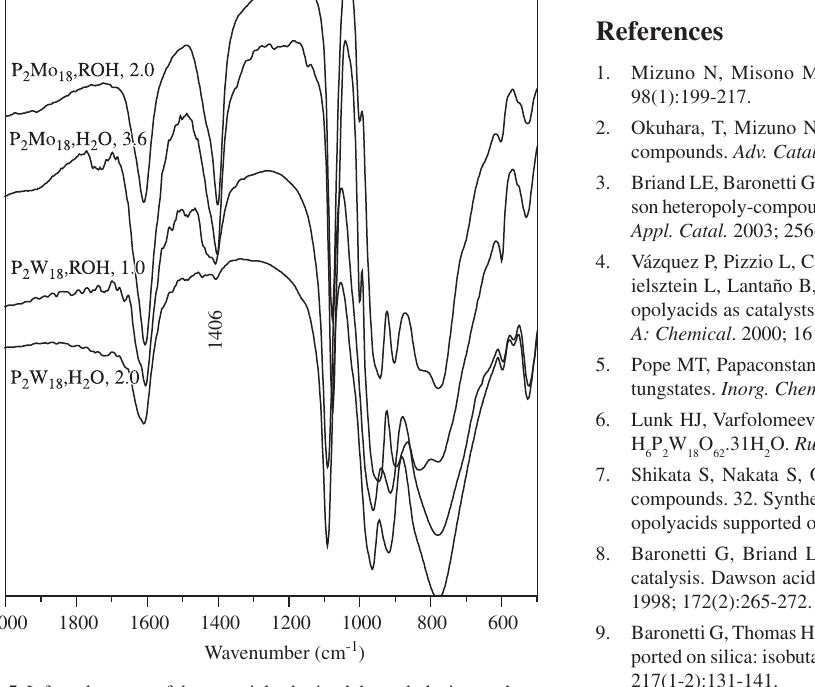
) P W O .13H O and (NH ) P Mo O .12H O salts in a column 4 6 2 18 62 2 4 6 2 18 62 2 W and P Mo for brevity), the solvent [aqueous and 2 18 2 18